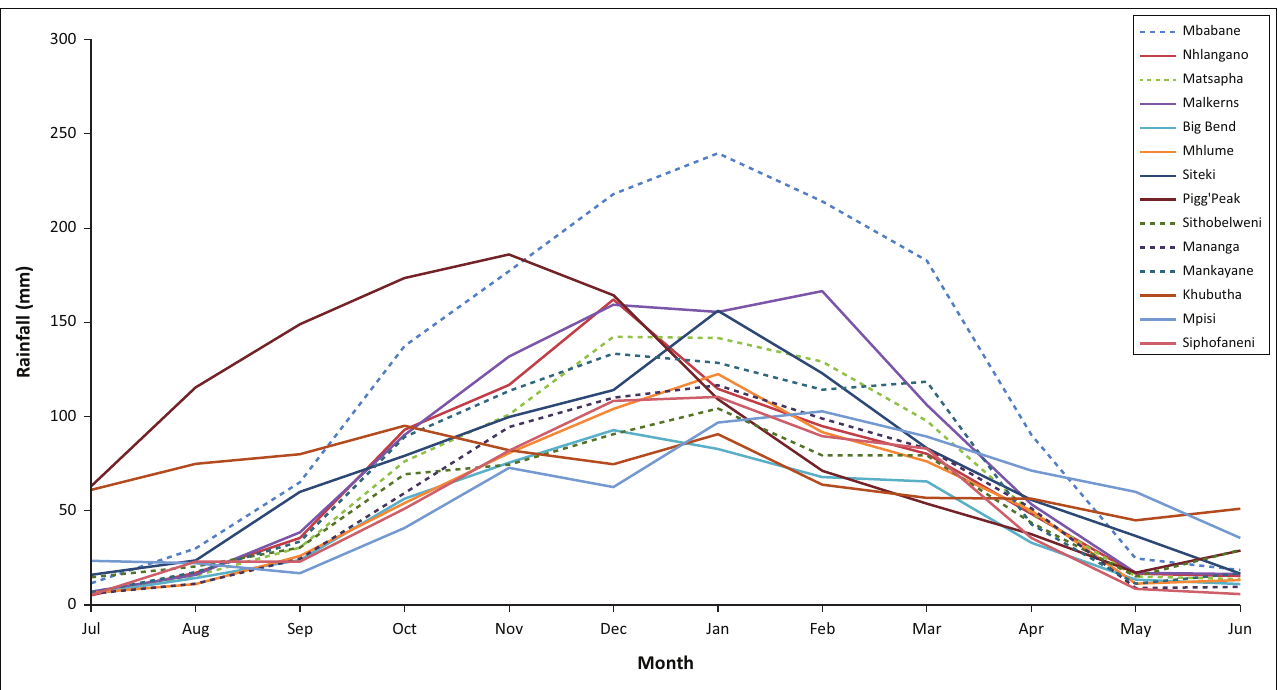
FIGURE 2: Mean historical monthly rainfall for Eswatini during the time period